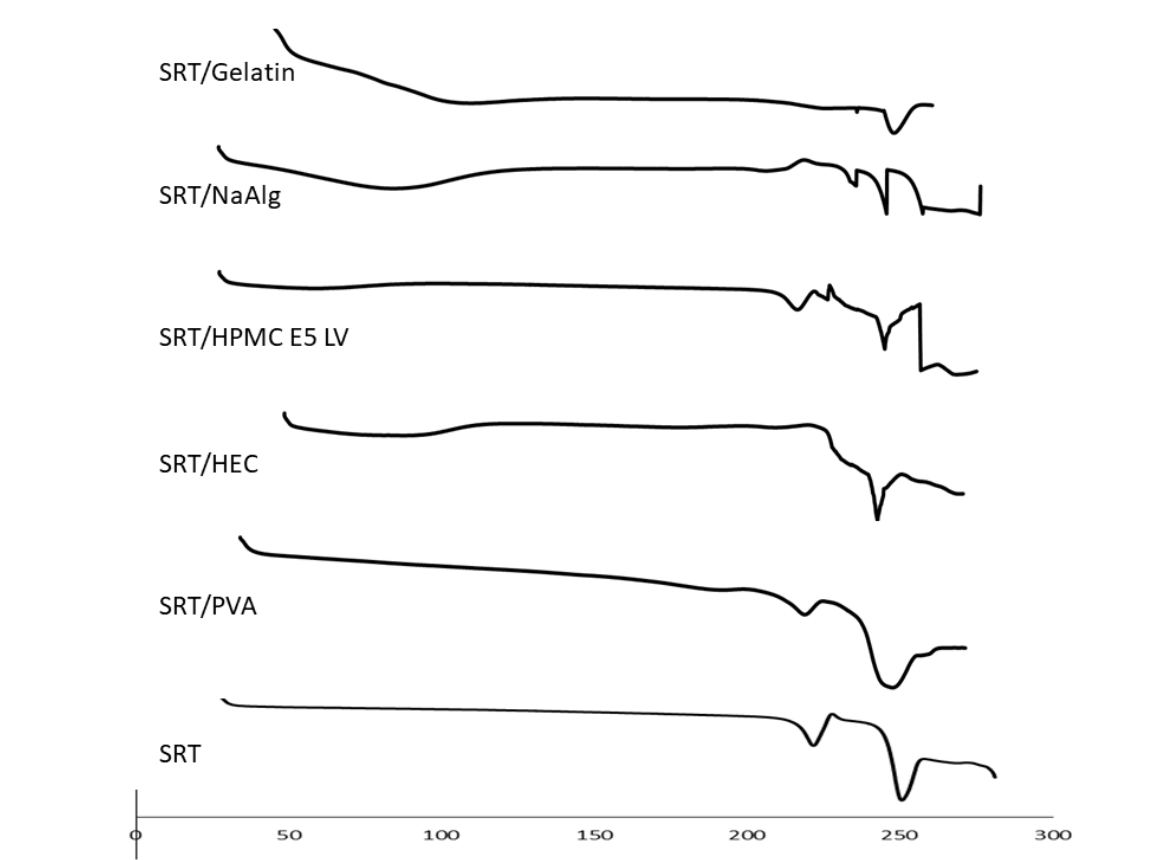
FIGURE 4 - DSC thermograms of SRT and its physical mixtures with different